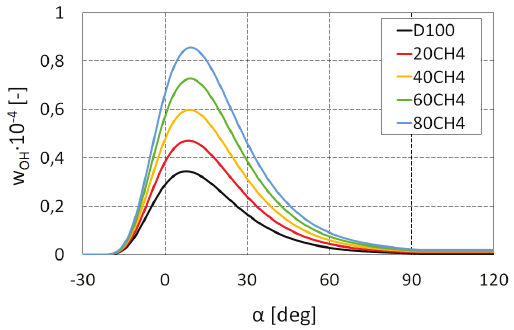
Fig. 6. Mass fraction of hydroxyl radicals – W OH for various methane content in fuel supplying the engine (engine speed 1800 rpm, engine load 80%)